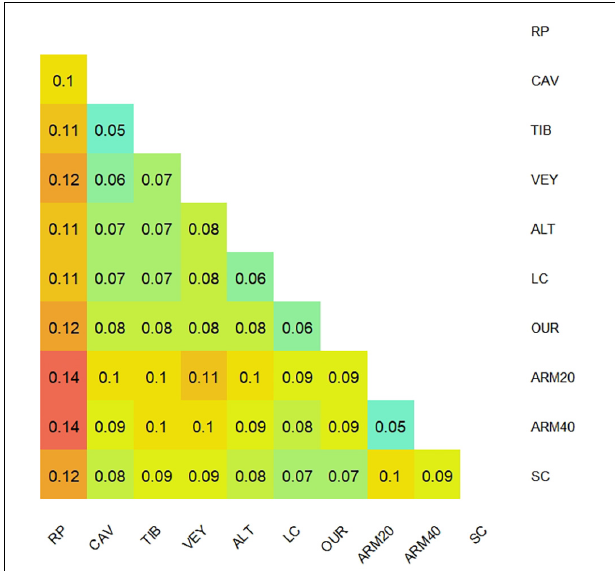
FIGURE 4 | Heatmap of pairwise F ST between populations of Ericaria zosteroides using the set of 10,755 SNPs putatively neutral SNPs. Pairwise genetic differentiation was reported as significant among populations (exact G test for genic differentiation, p <